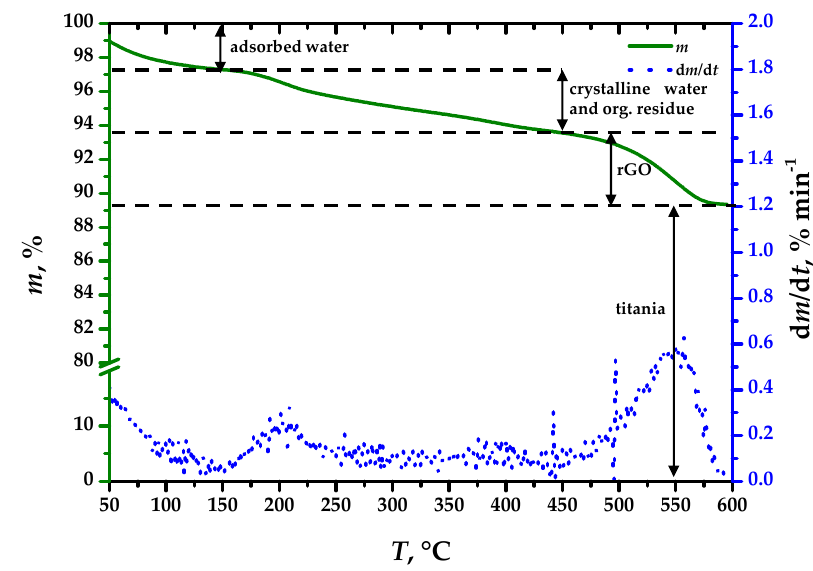
Figure 1. Thermogravimetric analysis of the S-TiO 2 /rGO(5.0%) composite.